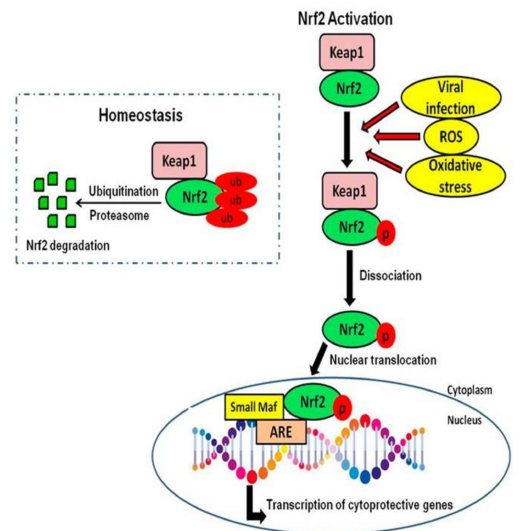
Figure 6. Nrf2 mechanism of action. Oxidative stress induces Nrf2 modification, leading to the release, stabilization, and Nrf2 nuclear translocation. Nrf2 binds to the ARE in the promoter re- gion, transcribing multiple antioxidant genes [145]. Nrf2, nuclear factor-erythroid factor 2-related factor 2; Keap 1, Kelch-like ECH-associated protein 1; ub, ubiquinated; p, phosphorylation; Maf, musculoaponeurotic fibrosarcoma; ARE, antioxidant response